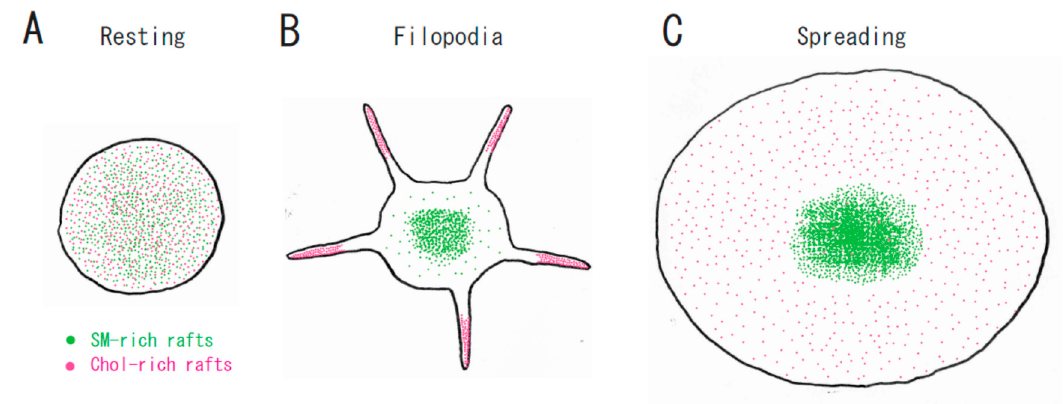
Figure 3. A spatial distinction between SM-rich rafts and cholesterol-rich rafts in platelets. ( A ) In resting platelets, SM-rich rafts (green) and cholesterol-rich rafts (red) are uniformly distributed on the cell surface. No spatial distinction is observed by confocal microscopy. ( B ) Cholesterol-rich rafts accumulate at the tips of filopodia of adhering platelets [12]. SM-rich rafts are mainly localized in the central area of adhering platelets with some distributed in the lamellipodia. ( C ) SM-rich rafts are in the central area of full spreading platelets. Cholesterol-rich rafts were localized evenly on the membrane [21].